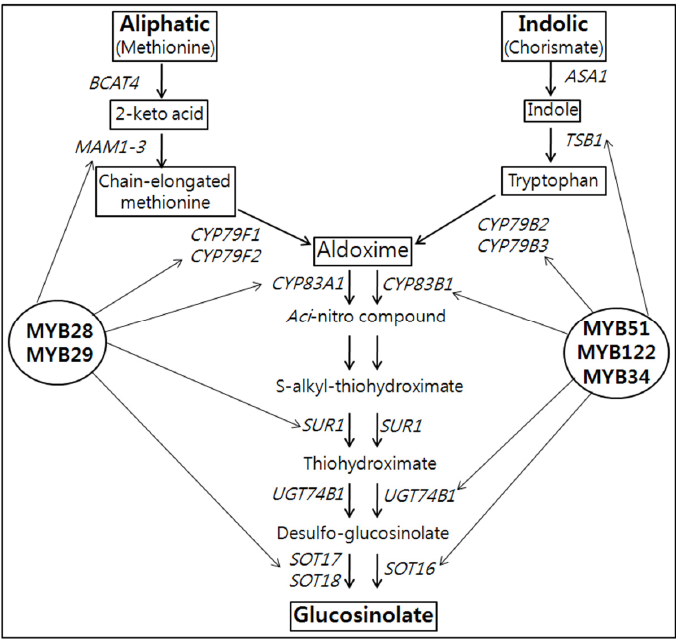
Figure 1. Schematic representation of the aliphatic and indolic glucosinolate biosynthesis in B. rapa [20]. The key MYB transcription factors involved in aliphatic and indolic glucosinolates are shown in bold. BCAT4, MAM1-3-Side-chain elongation; CYP79F1, CYP79F2, CYP79B2, CYP79B3, CYP83A1, CYP83B1, SUR1, UGT7B1-Core